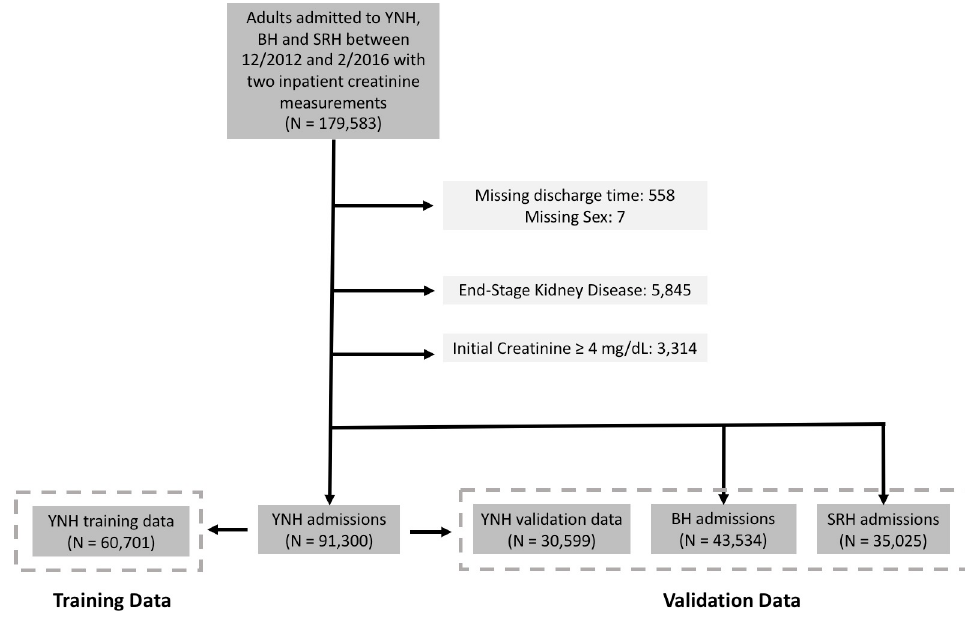
Fig 1. Flow diagram of the patient cohort with distribution of data among training and validation data